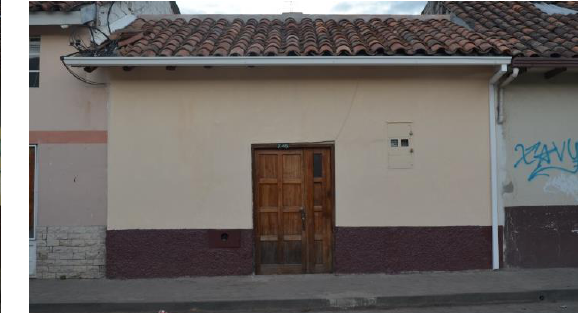
Figure 6. After the Herrerías Maintenance Campaign Source: City Preservation Management